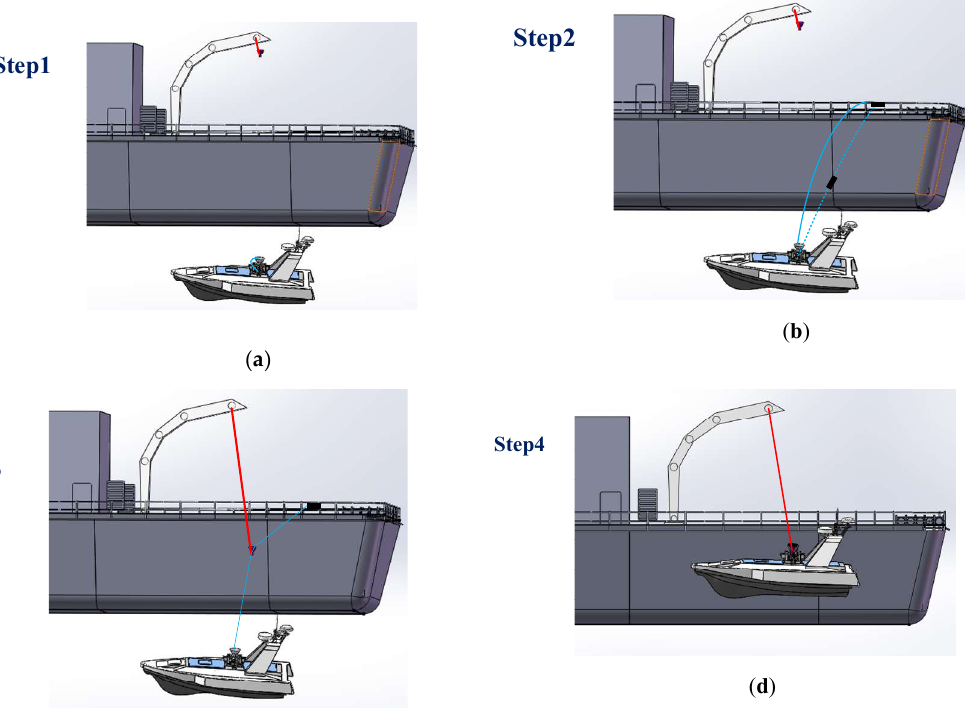
Figure 11. Flow chart of the recovery process. ( a ) Step 1. ( b ) Step 2. ( c ) Step 3. ( d ) Step 4. Table 2. The test results of the ejection mechanism.